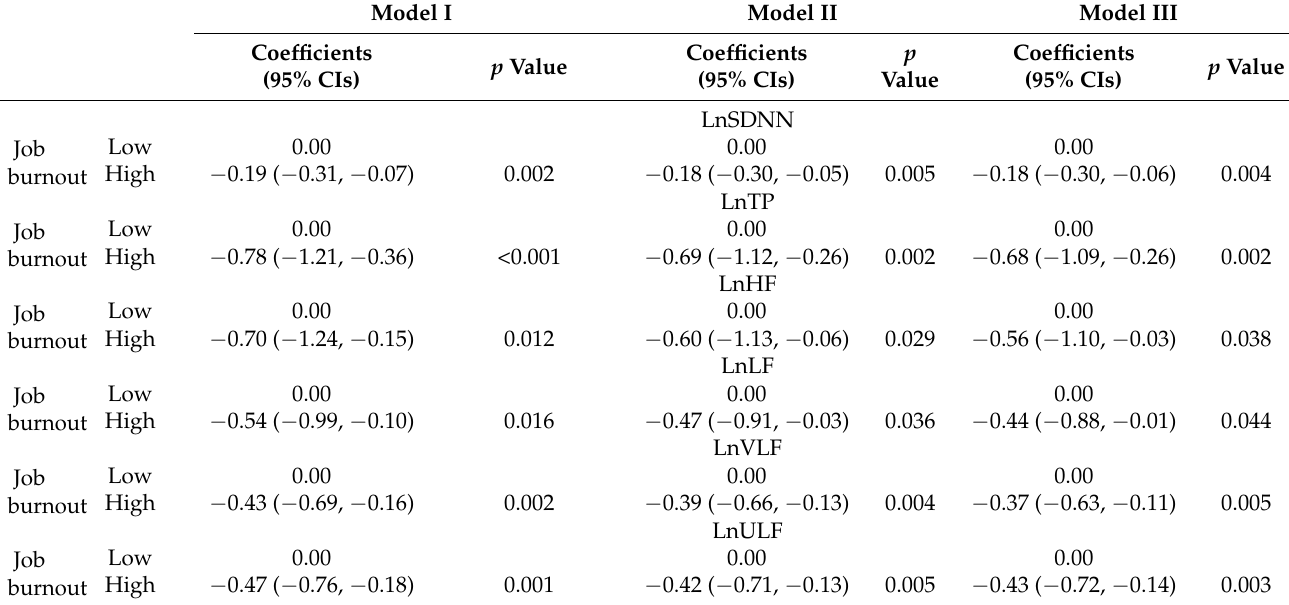
Table 3. The coefficients and 95% CIs of repeated measures of HRV parameters during follow-up by job burnout at baseline. Model